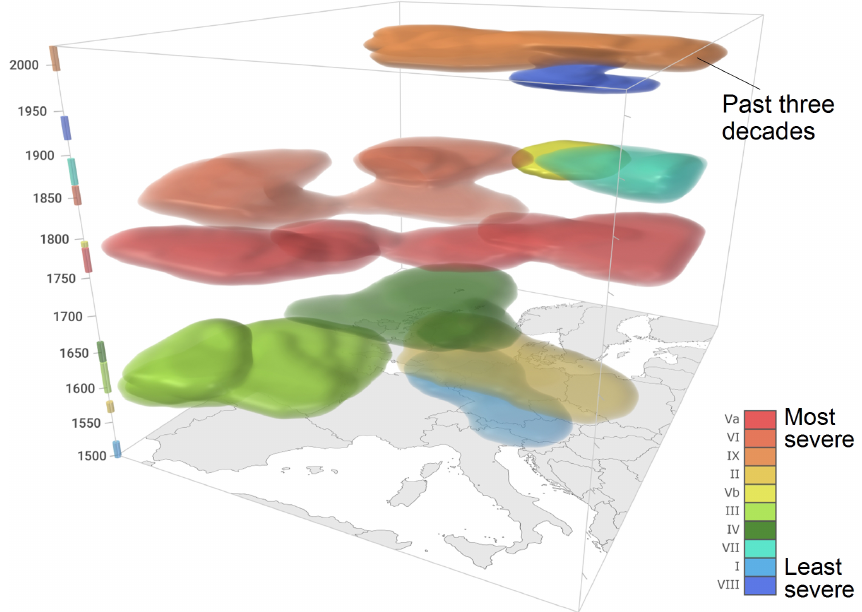
Figure 12. Flood-rich periods in the last 500 years in Europe defined as periods and regions in which floods are much larger and more frequent than usual. The flood-rich periods were identified from 103 high-resolution historical flood series based on documentary evidence. The past 3 decades were among the most flood-rich periods (Blöschl et al., 2020).